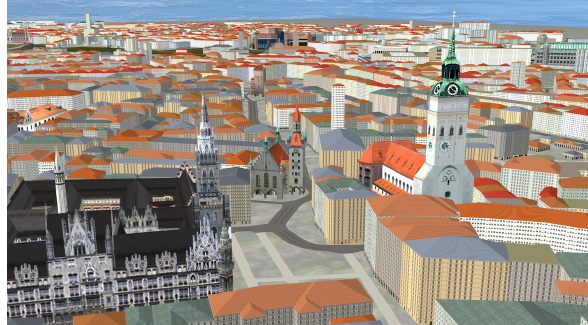
Figure 3: Mixed-LoD 3D city model of Munich by NAVTEQ as a combination of the Enhanced 3D City Model, and 3D Land- marks. Source: